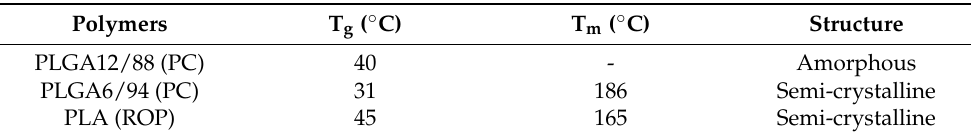
Table 2. Thermal transitions for PLGA copolymers and PLA recorded from DSC (10 ◦ C min − 1 ). Polycondensation (PC), ring opening polymerisation